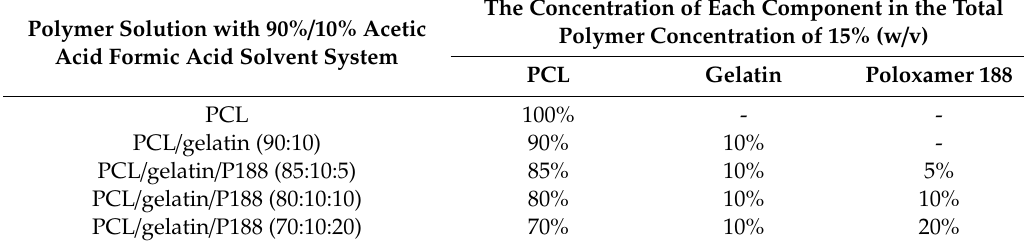
Table 1. Di ff erent polymer solutions prepared along with the concentration of each component (in %w / v) used to prepare the polymer